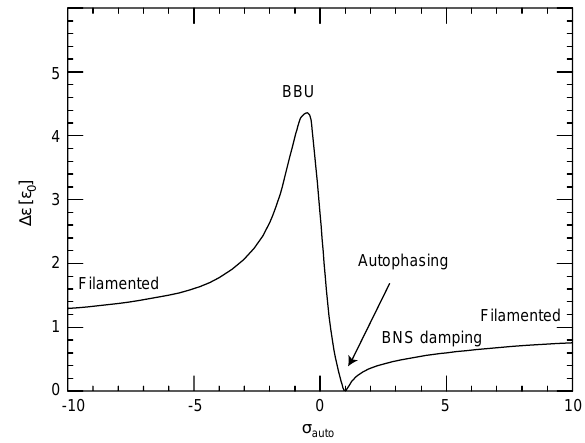
p FIG. 5. Emittance growth for a 2 s initial transverse offset versus correlated energy spread in units of the optimal energy spread for autophasing after the first 10% of the NLC linac; FIG. 6. (Color) Ideal autophasing energy spread for a Gaussian note the different regimes with filamentation at s d ¿ s auto bunch in the beginning of the NLC linac with a bunch length or ø s auto , beam breakup when s d (cid:10) 0 , BNS damping when of s z (cid:1) 125 m m and N (cid:1) 1 3 10 10 ; the head of the bunch is s d . s auto , and autophasing when s d (cid:1) s auto . to the left. Note the nonlinear correlation which is difficult to